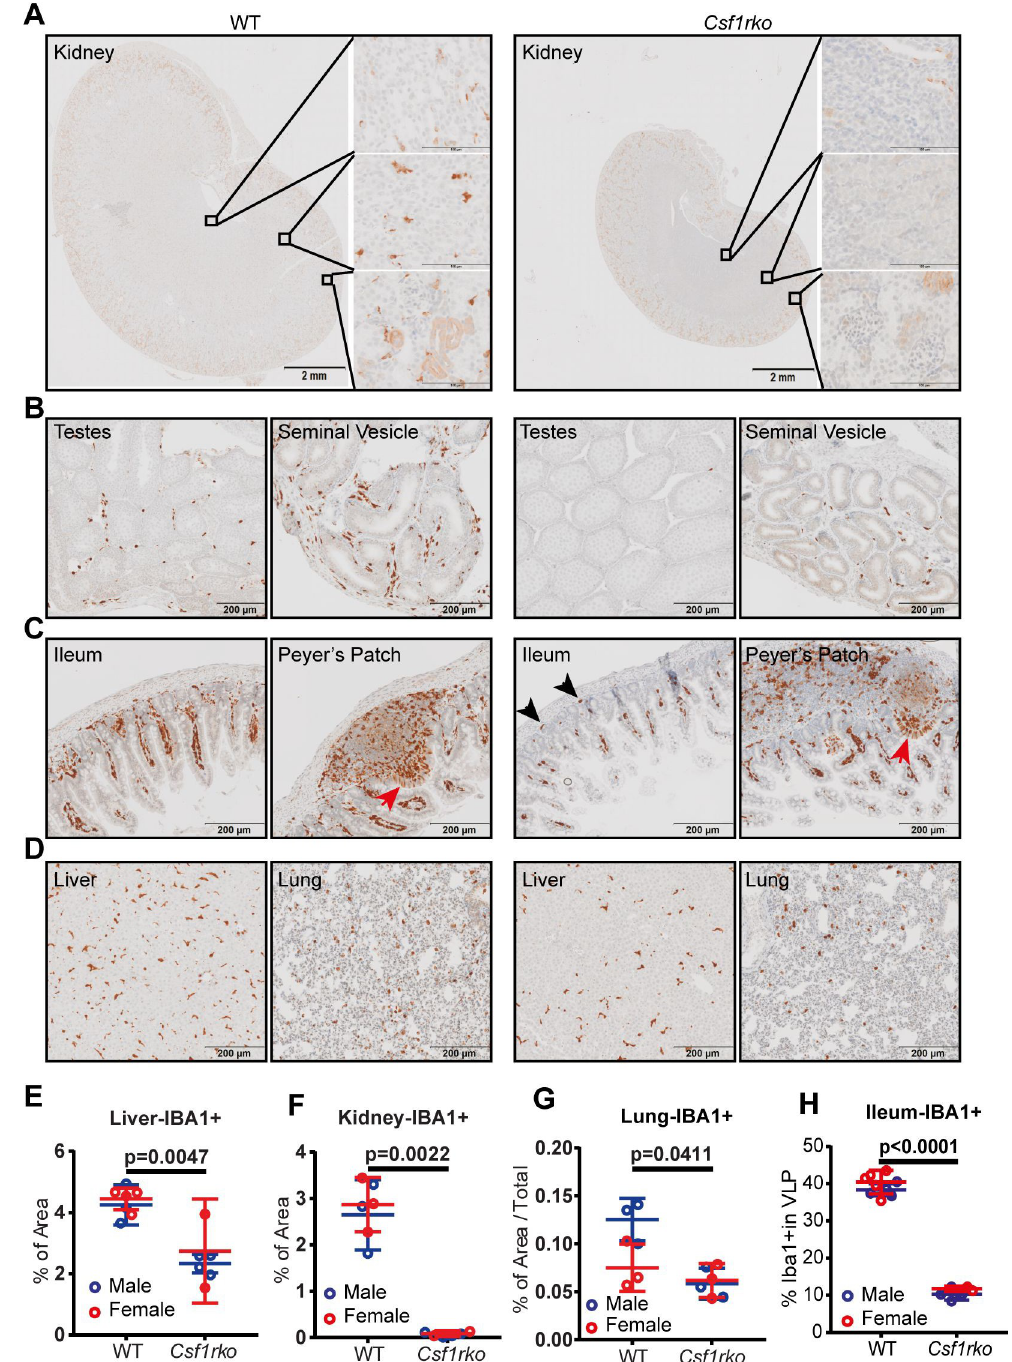
Fig 8. Immunolocalization of IBA1 + cells in WT and Csf1rko rat organs at 3 wks. IBA1 was detected in rat tissues by immunohistochemistry as described in Materials and Methods. Brown stain (diaminobenzidine) is a positive signal; sections were counterstained with haematoxylin (blue). (A-D) Representative images of immunohistochemical localisation of IBA1 in (A) kidney, (B) testes and seminal vesicles, (C) ileum including Peyer’s patches and (D) liver and lung of WT and Csf1rko rats. M cells in the follicle-associated epithelium are indicated by red arrows. Black arrowheads highlight IBA1 + cells in the base of the crypts in (C). (E-H) Quantitative analysis of IBA1+ cells in (E) liver, (F) kidney, (G) lung and (H) ileum (lamina propria). n � 6 per genotype, graphs show the mean ± SD, genotype comparisons were analysed by Mann Whitney test.